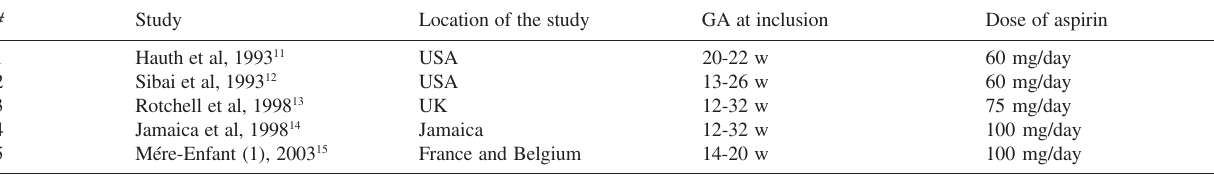
Table 1 - Characteristics of randomized trials including women at low risk for